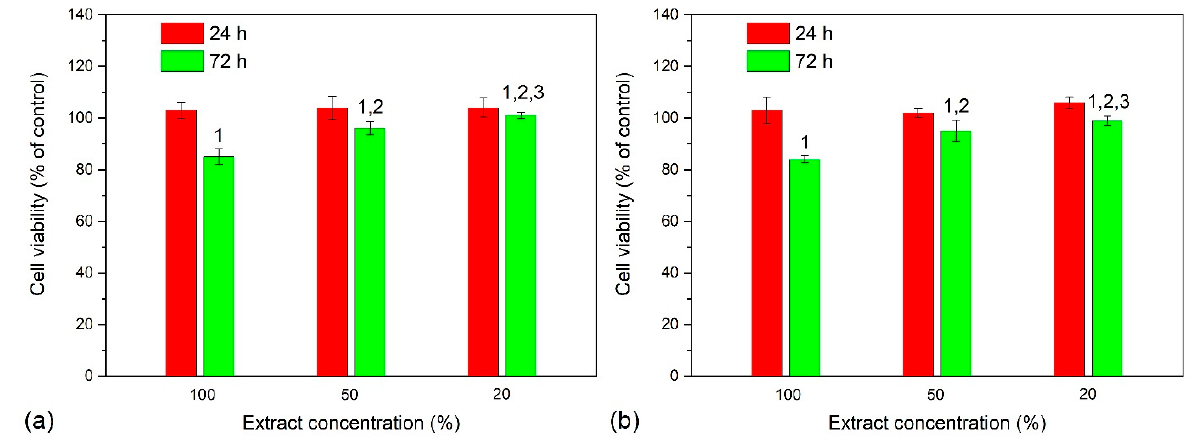
Figure 5. Viability of EA.hy926 cells after 24 and 72 h incubation with extracts: ( a )—T1 substrates, ( b )—T2 substrates. Data are presented as mean ± SD. 1— p < 0.05 compared to 24 h, 2— p < 0.02 compared to 100% extract after 72 h, 3— p < 0.05 compared to 50% extract after 72 h. Each group consists of six substrates for testing.